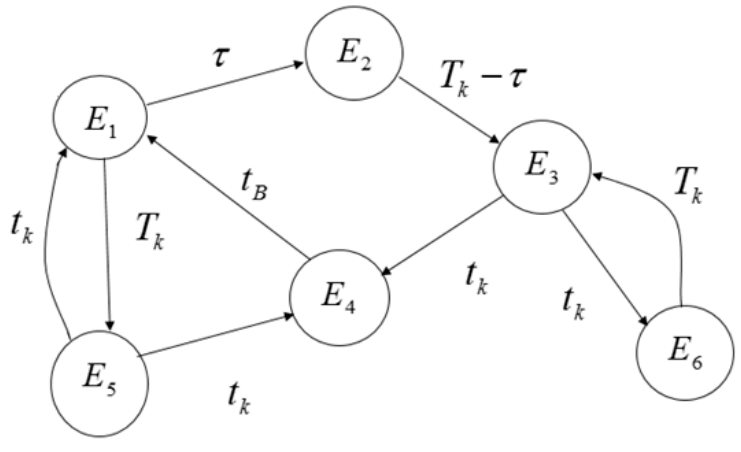
Figure 1. Graph of state transitions.